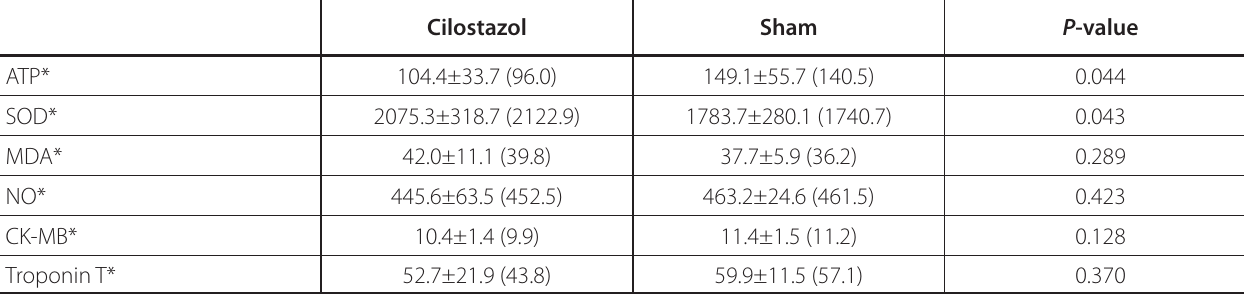
Table 1 . Comparison of biochemical markers between the cilostazol and sham